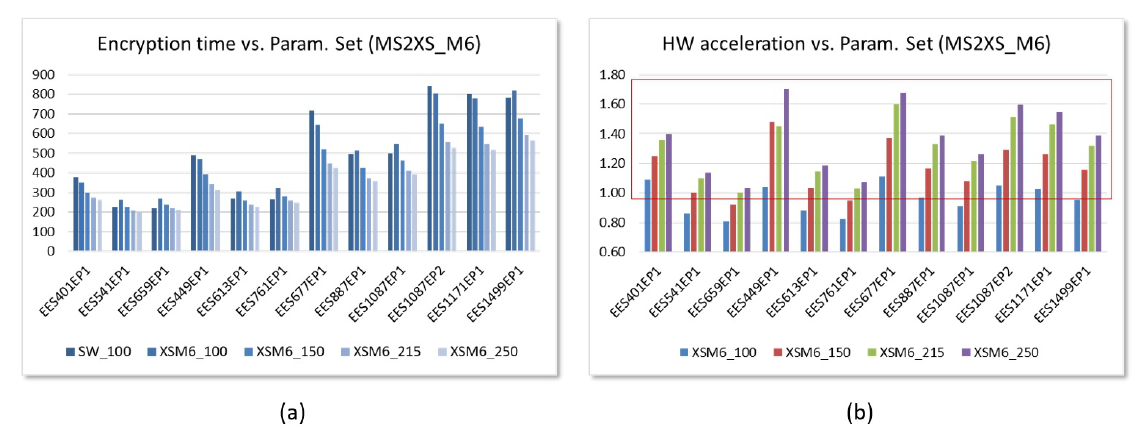
Figure 23. Evolution versus number of arithmetic units of the time invested ( a ) and the acceleration factor reached ( b ) in the encryption operation using the parameter sets defined in IEEE Std 1363.1 for SW and HW/SW embedded systems implemented on the Ultra-96 board using AXI4-Stream IPs (time displayed in µ